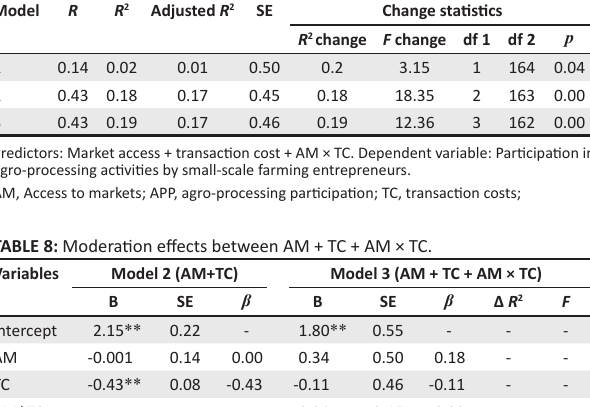
TABLE 7: Regression summary for APP and AM (Model 1) + TC (Model 2) moderation effect + AM × TC (Model 3). Model